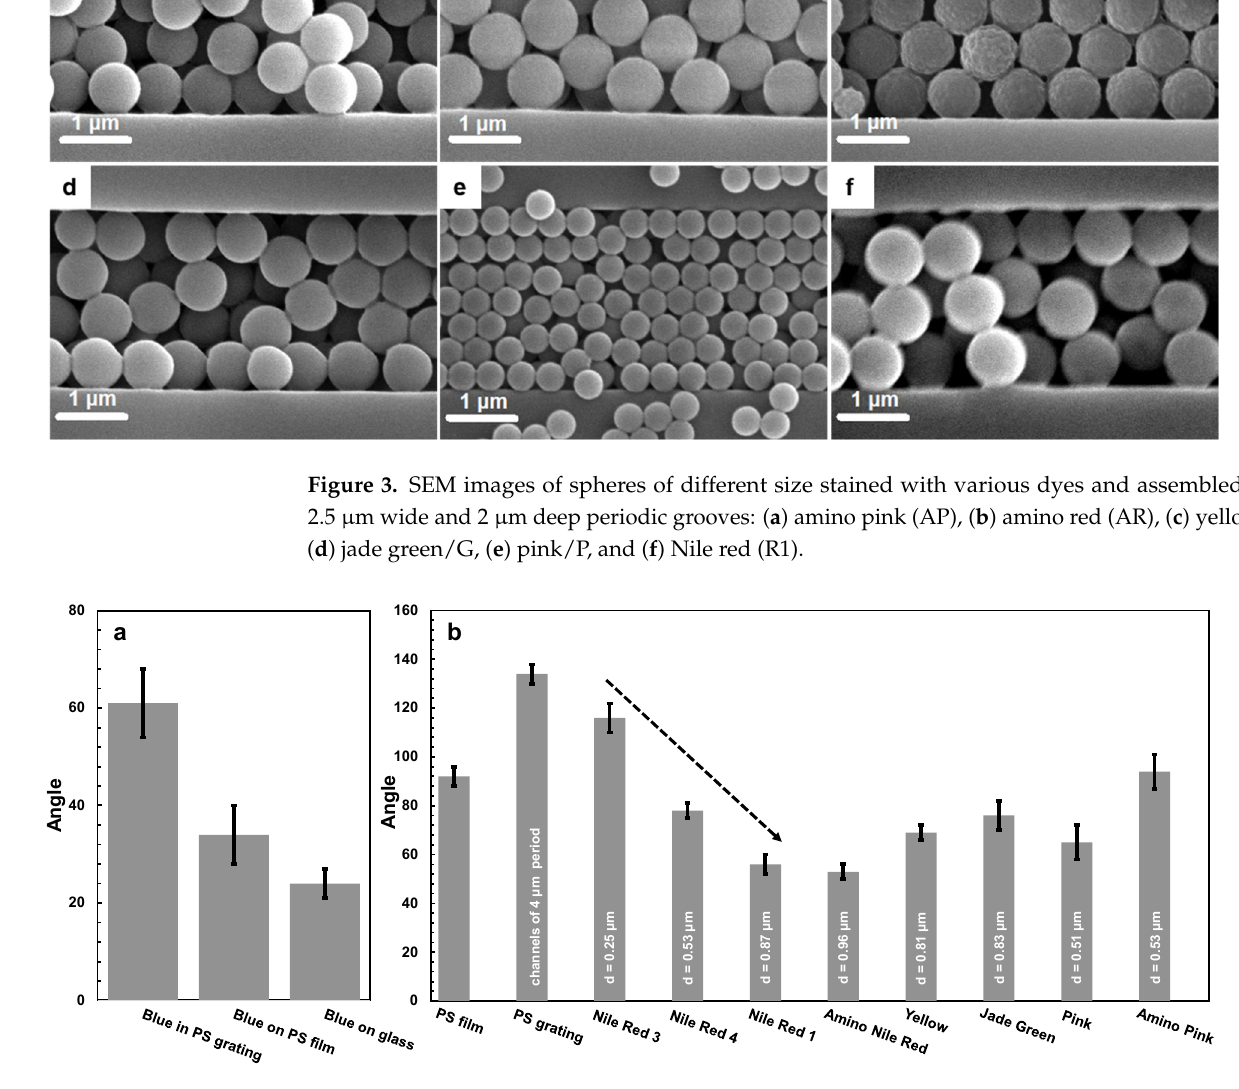
Figure 4. ( a ) Comparison of the contact angle displayed by surfaces fabricated by spin-casting the blue-dyed B spheres on a glass substrate and on a PS-covered glass substrate, and by their incorporation into a PS grating. ( b ) Contact angles measured for spheres of different diameter and fluorescent function incorporated into PS gratings, as compared to the contact angles of PS-covered glass and an empty PS grating.